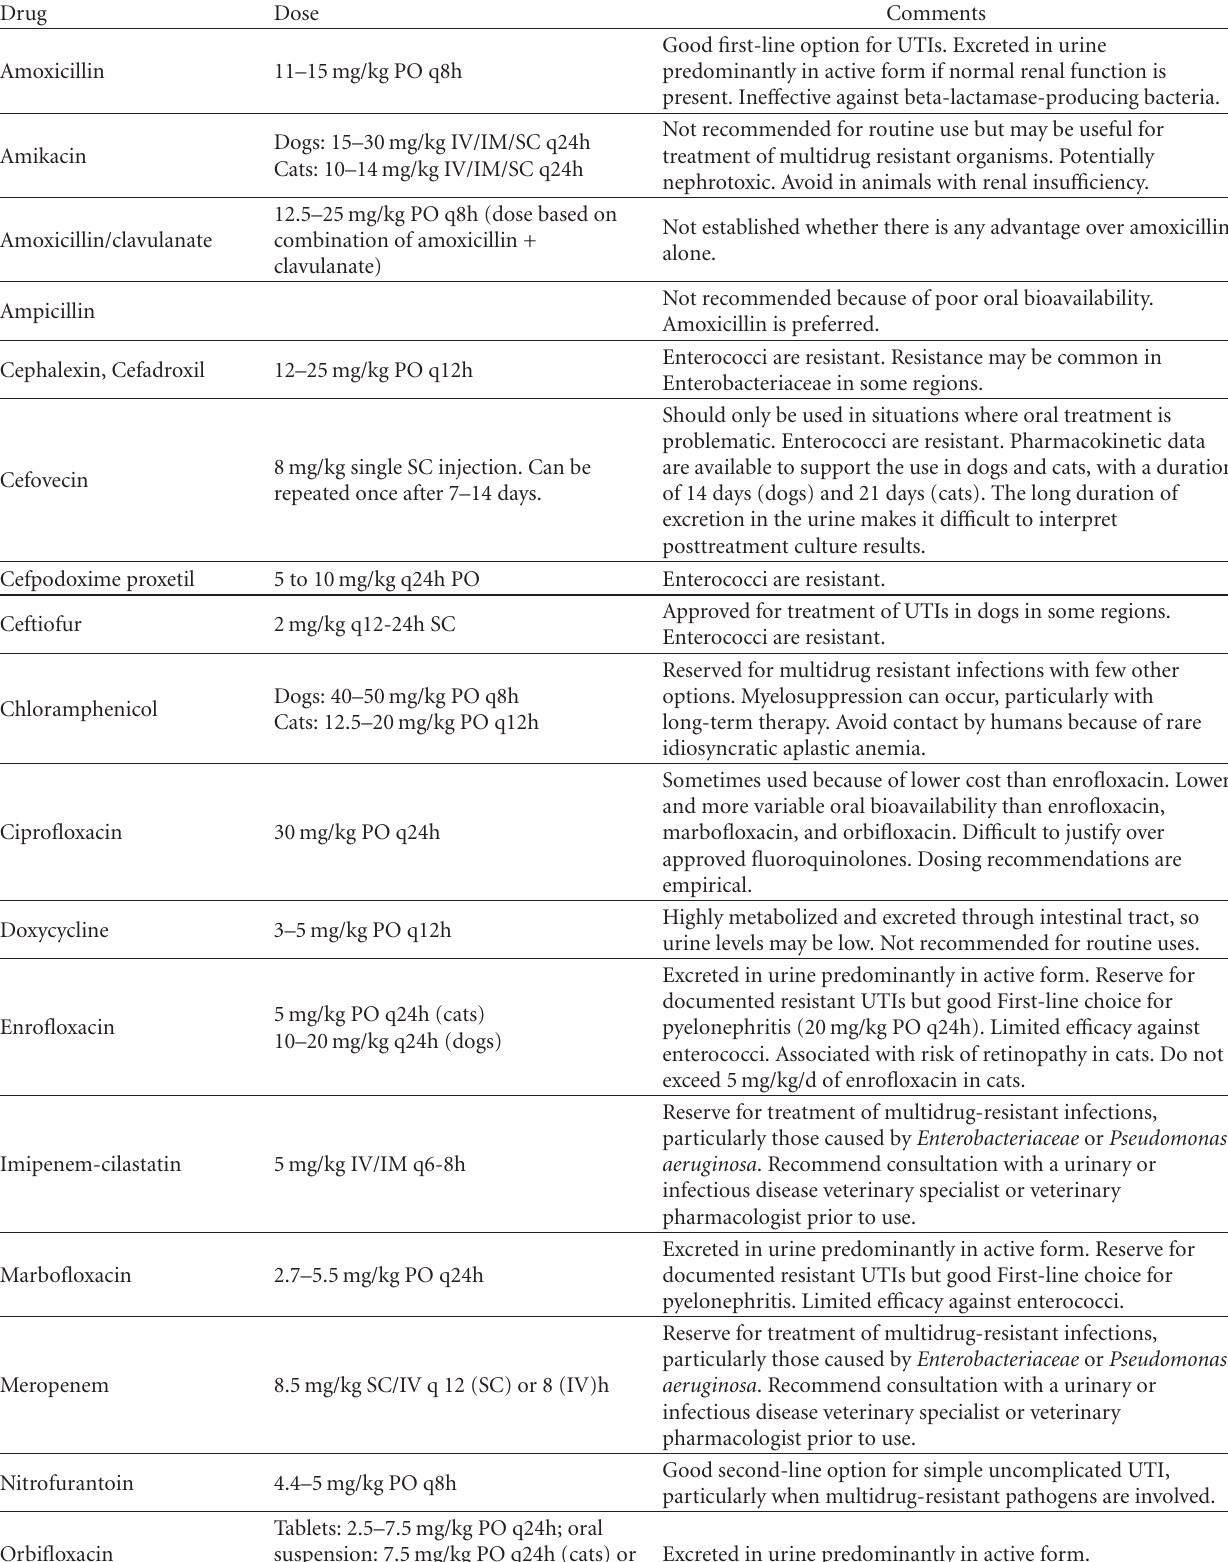
Table 2: Antimicrobial treatment options for urinary tract infections in the dog and